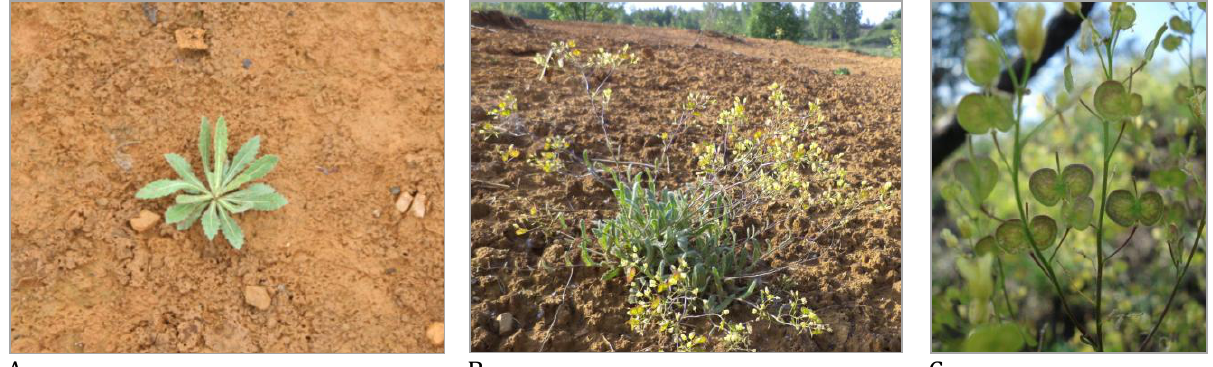
Fig. 1. The habit of plants of Biscutella laevigata : A) rosette leaves ( A. Rostański ), B) flowering plant ( A. Rostański ), C) fruiting shoots ( M. Jędrzejczyk-Korycińska )